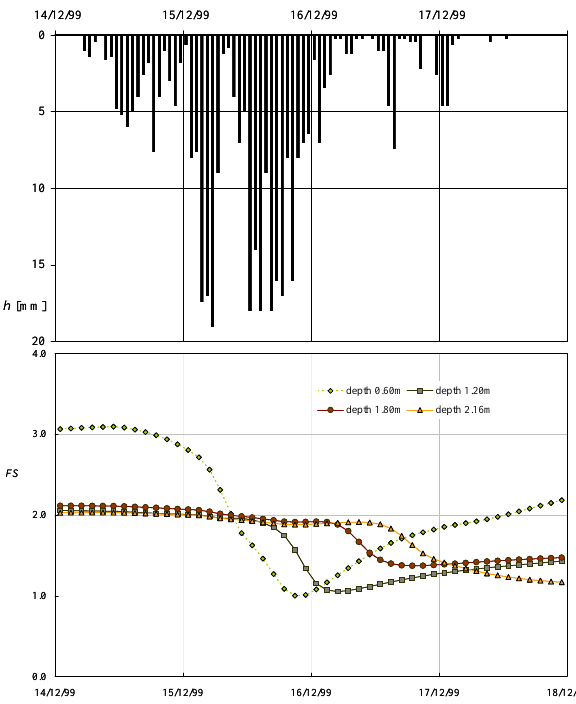
Fig. 9. Hourly hyetograph (above) and simulated trend of the safety Figure 9 factor at various depths (below) during the event of December 1999 evaluated for the mean slope inclination angle (40 ◦ ). The safety fac- tor has been evaluated with the limit equilibrium Eq. (14) under the hypothesis of infinite slope geometry.